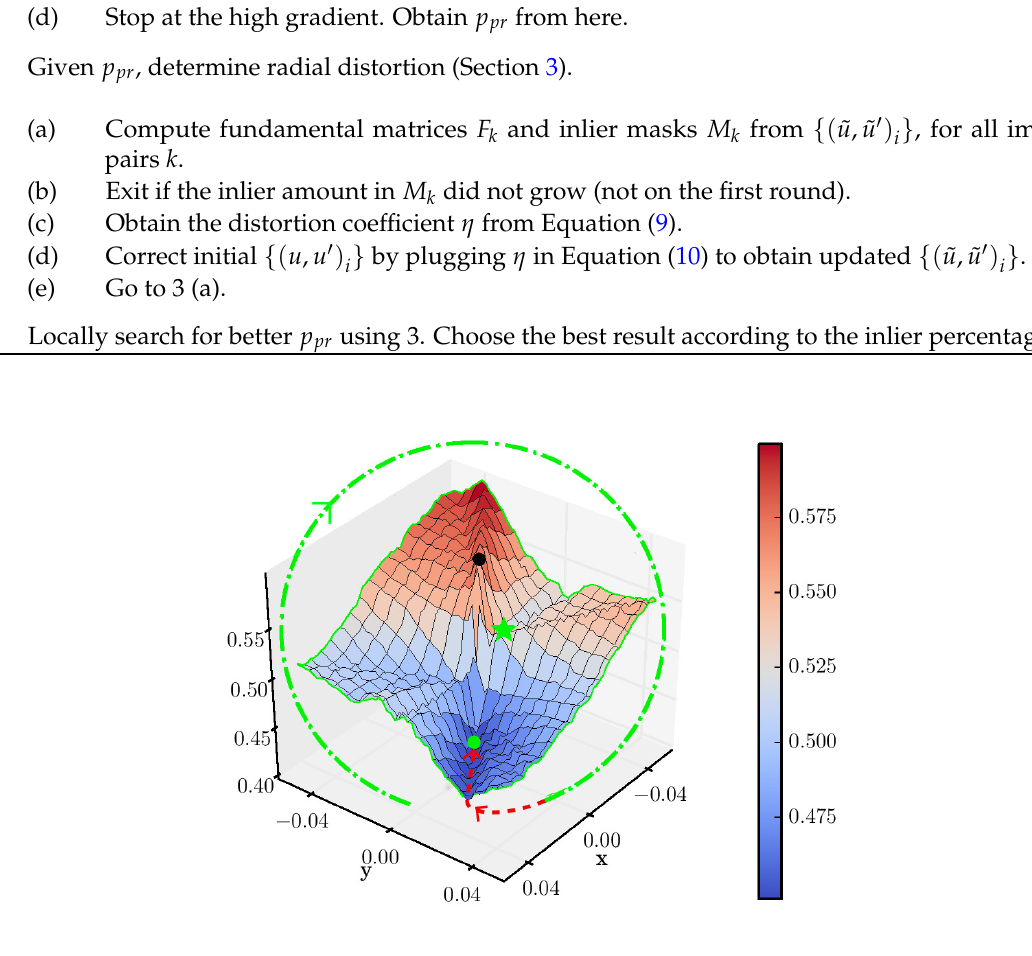
Figure 4. Energy surface depicting the symmetry ratio r s = r s ( p pr ) , where the x- and y-axes span the location of p pr . A low/blue (high/red) ratio indicates a favorable (unfavorable) position for p pr in terms of barrel distortion symmetry. The surface is non-convex. The best trial for the center of distortion p pr is found at the bottom of the valley. The EPOS result is shown with a big (green) dot in the deepest valley. The (black) dot on the ridge represents its mirror location. The reference result from bundle adjustment (BA) is shown with a big star in an upper valley. Green and red dotted lines represent how the scouting of the symmetry landscape is done; see Section